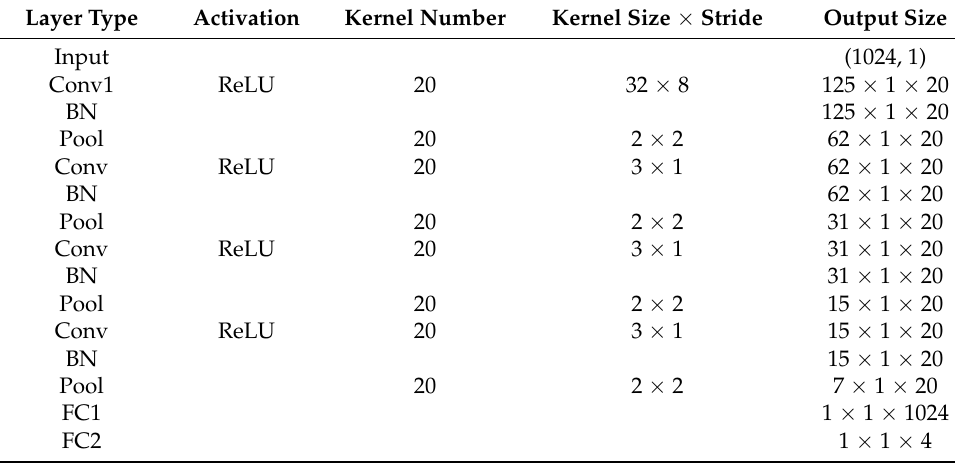
Table 1. Detailed settings of the WDCNN